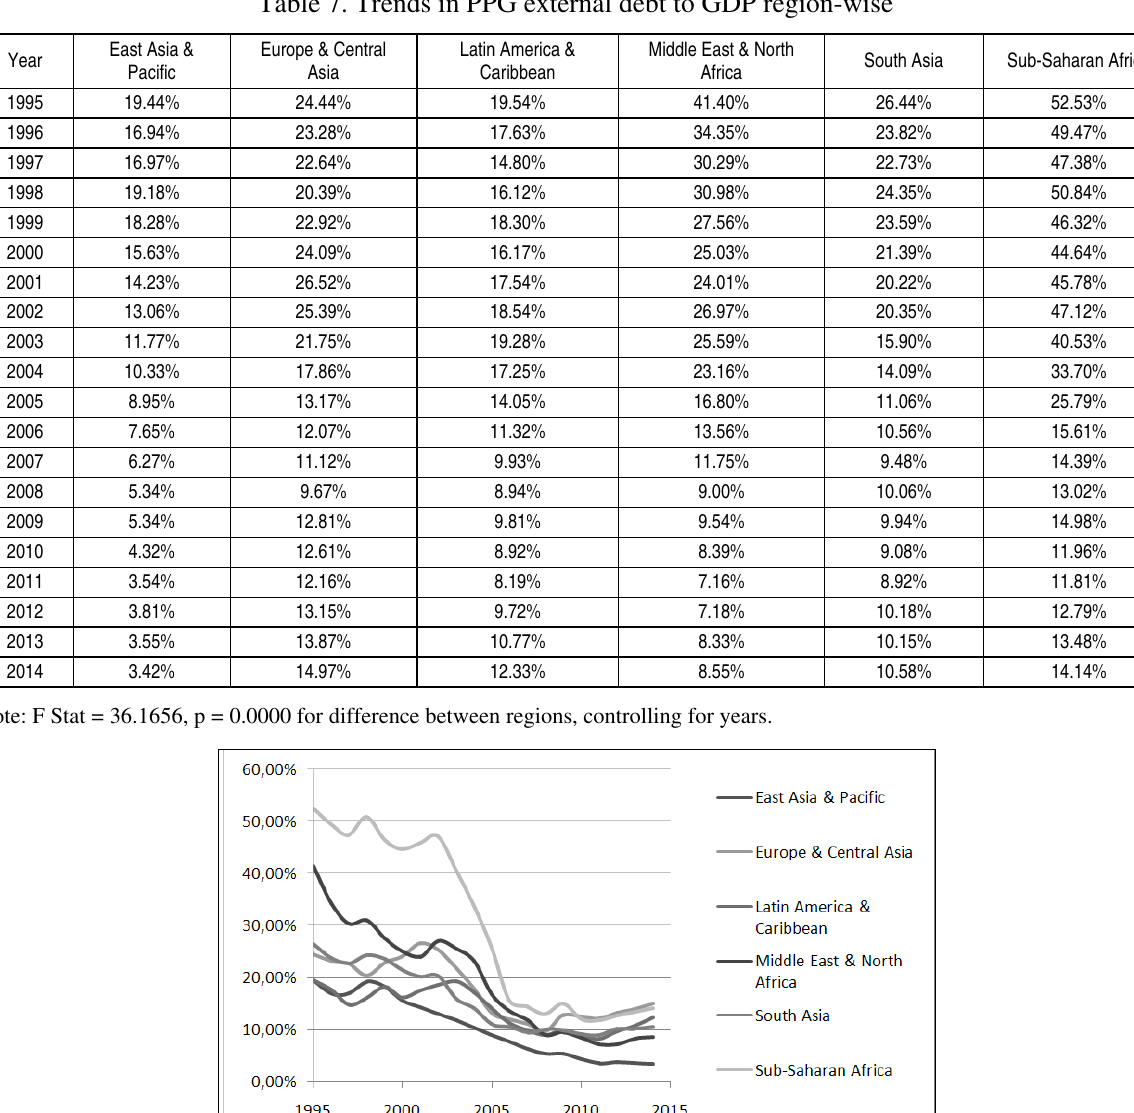
Table 7. Trends in PPG external debt to GDP region-wise